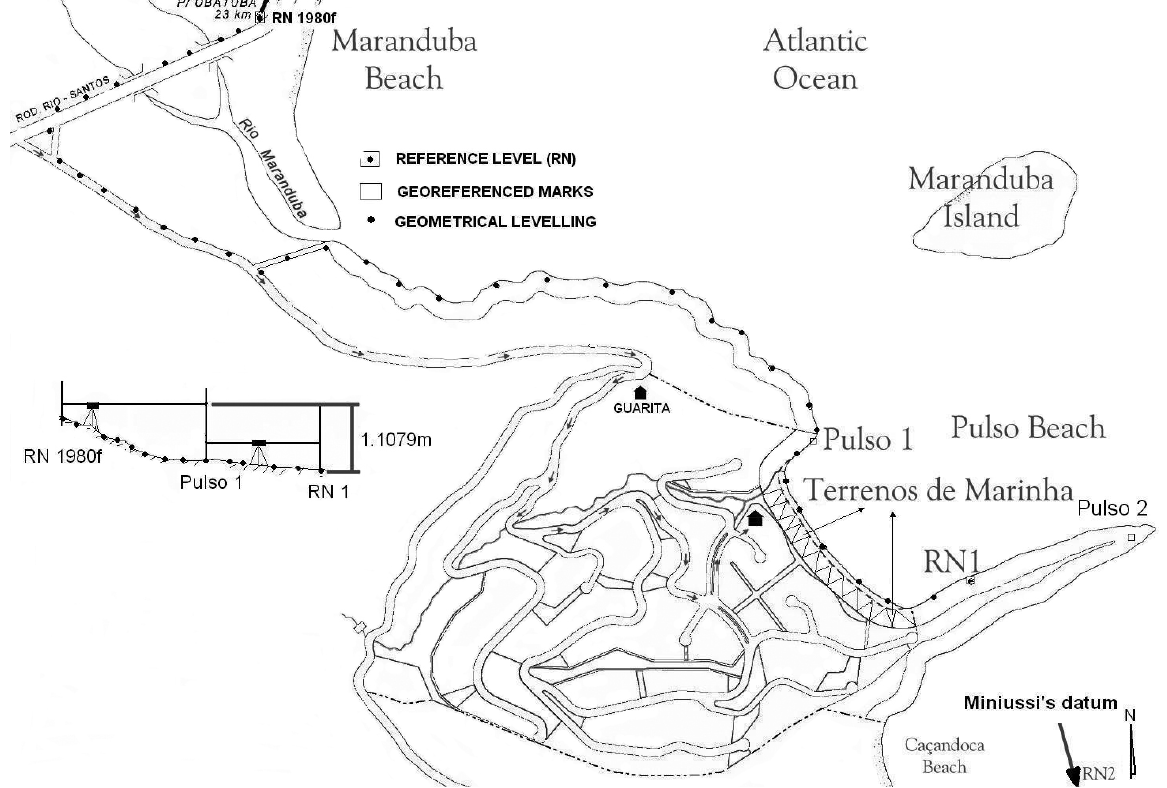
Fig. 2 – Leveling at Praia do Pulso (PP), with the indications of locations where the reference level was fixed for geo-referencing and positioning for sea level measurements – (PULSO1- PULSO2-, RN1) and the indication of the Caçandoca Beach, to where the leveling work was also